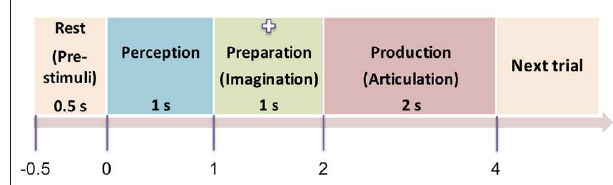
FIGURE 2 | Protocol of the time-locked experiment. The four time-locked stages of the experiment ( rest → perception → preparation → articulation ) are shown here. The numbers represent the initial onset time of the stages. Next trial starts with a non-movement baseline of 1s. The screen was blank in dark background during the pre-stimuli stage. A stimulus (text) was displayed on the screen during the perception segment, then replaced by a cross sign during the preparation stage. The cross disappeared (blank display) again during the production